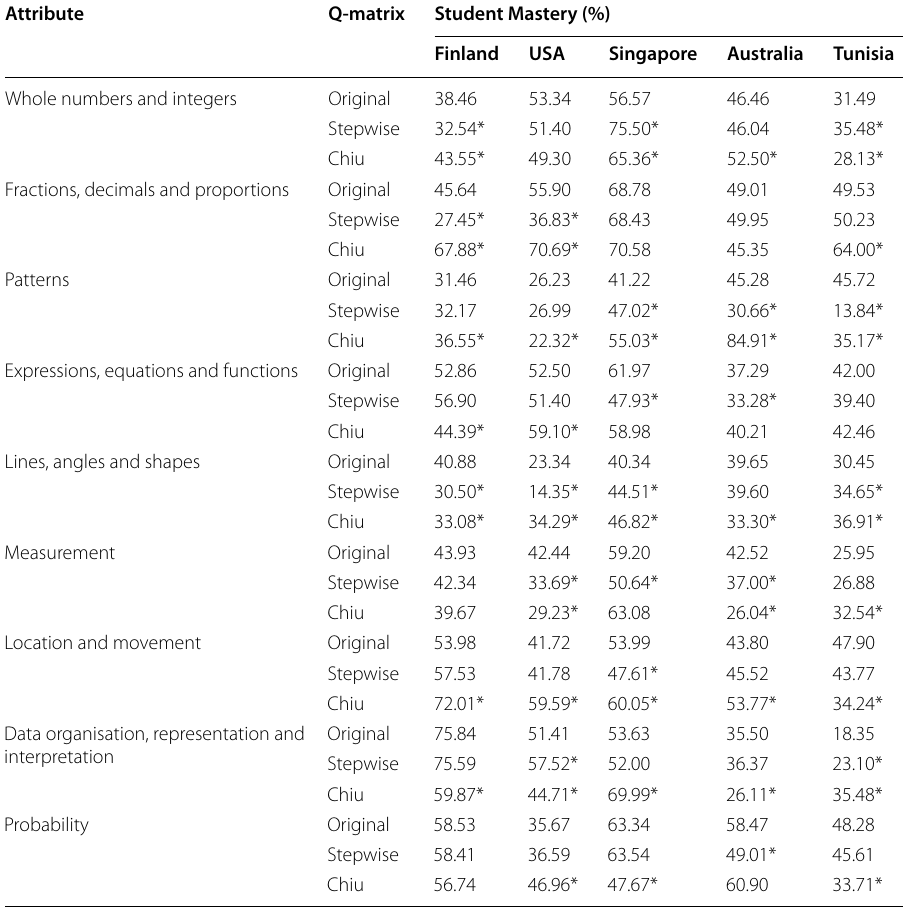
* difference in student attribute mastery between the original and the refined Q‑matrix greater than 10%